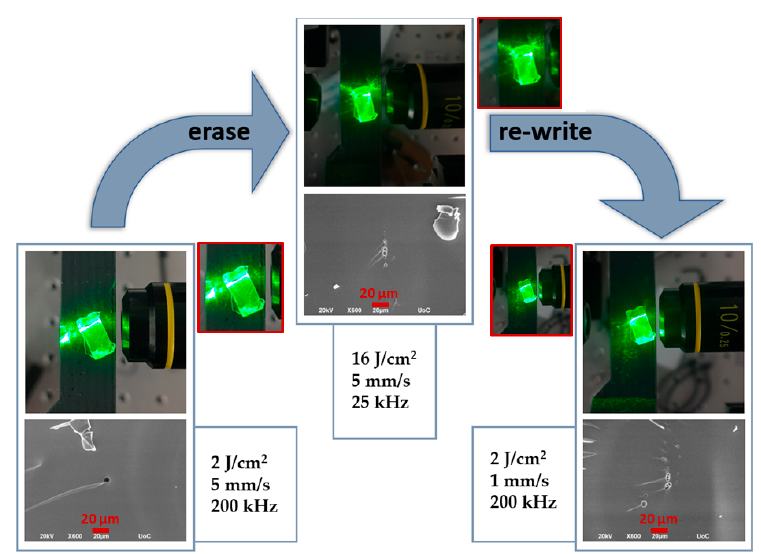
Figure 6. Images visualizing the waveguiding effect along with the corresponding SEM images at the cross-section of the processed glass areas. After initial fabrication ( left ), at the erase of the written waveguide ( middle ) and the re-make of the waveguide ( right ) at the same glass spot. The insets (red squares) show enlarged photos of the waveguides.